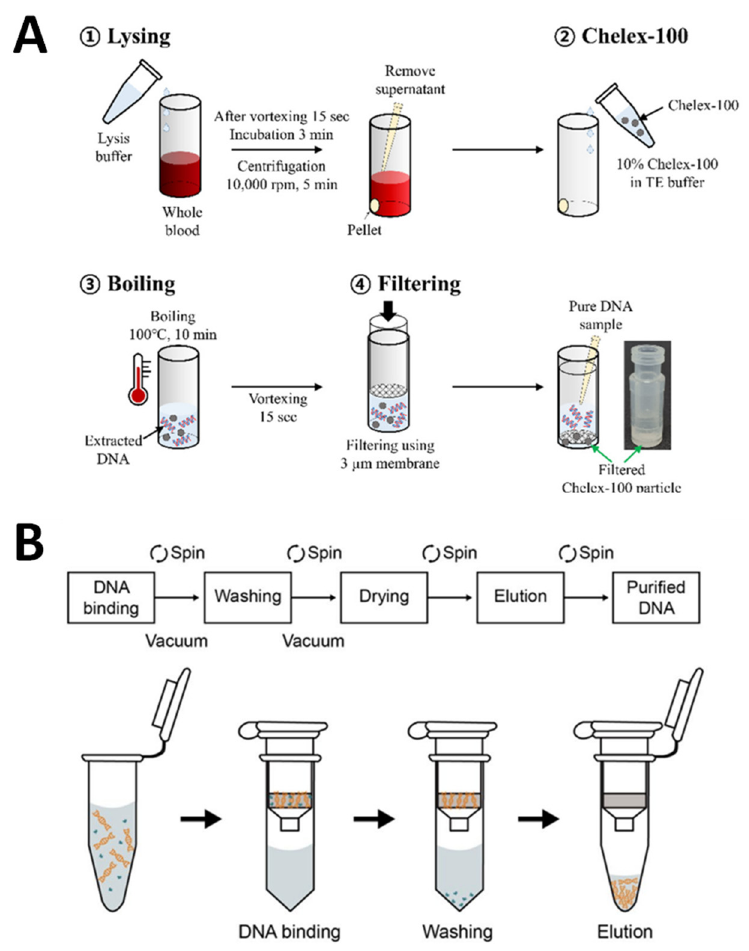
Figure 15. Schematic representation of DNA extraction for real sample measurements. ( A ) Conven- tional methods and ( B ) commercial DNA extraction kits. Figure 15A was adapted from Ref. [73], while Figure 15B was retrieved from Ref. [74].